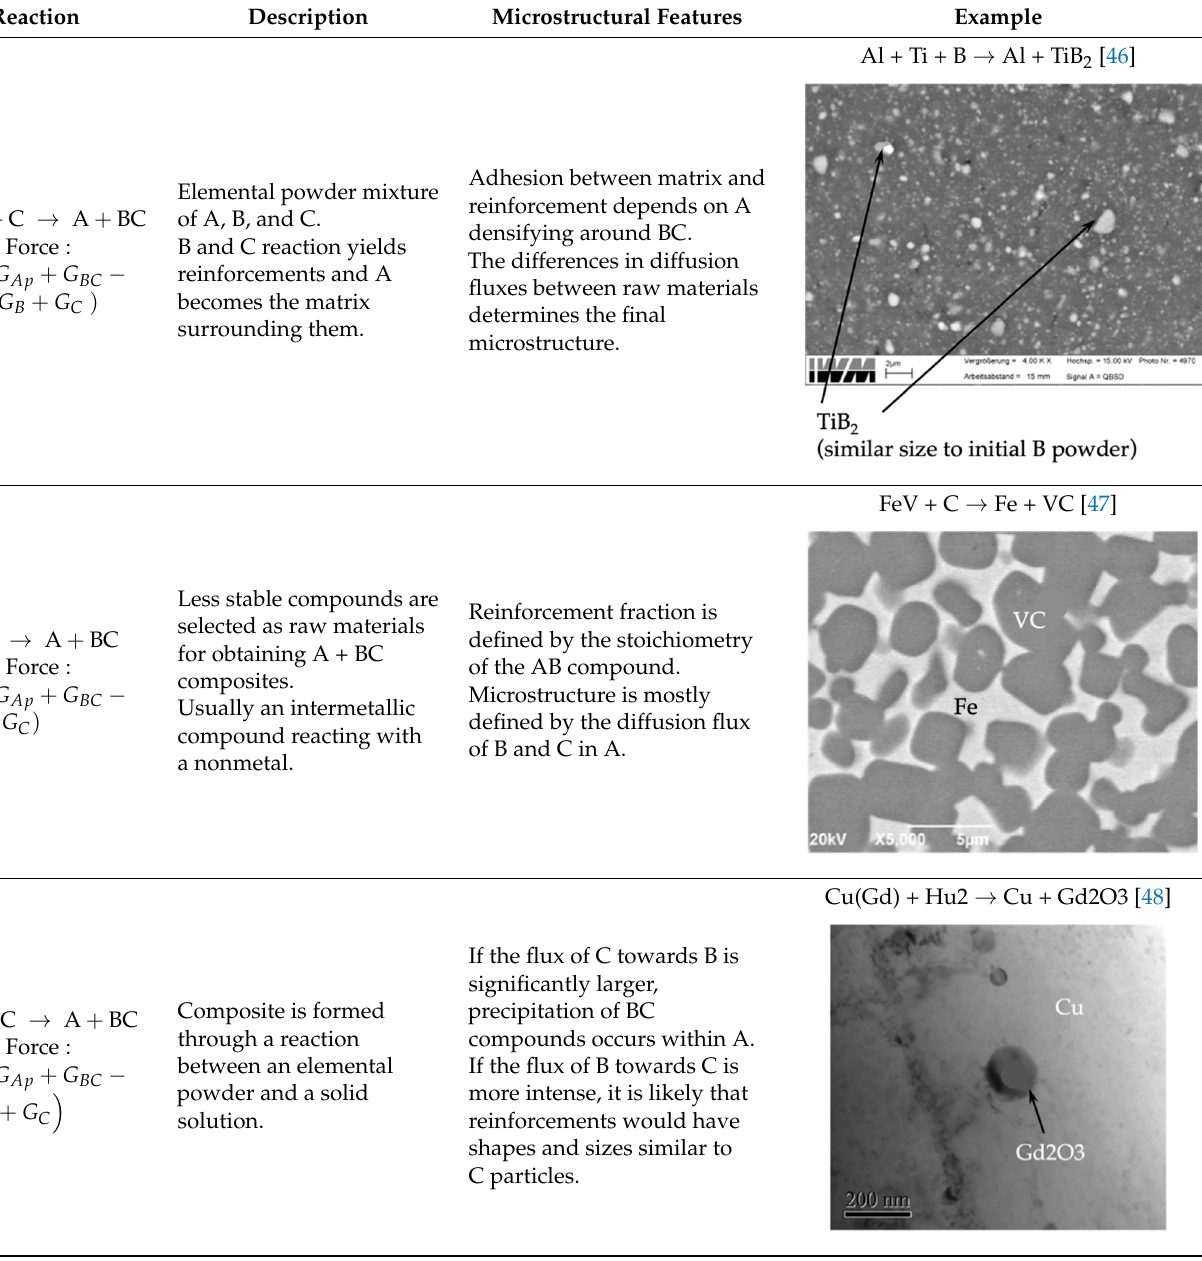
Table 2. Raw material possibilities for composites of type A + BC. ∆ G is the Gibbs free energy change of the reaction, G is the Gibbs free energy of element i. R and P subscripts in the fourth column stand for reactant and product amounts of A, respectively. For the sake of simplicity, there is no mass balance in the reaction equations. Figures in the “examples” column are meant to illustrate microstructural features listed in the